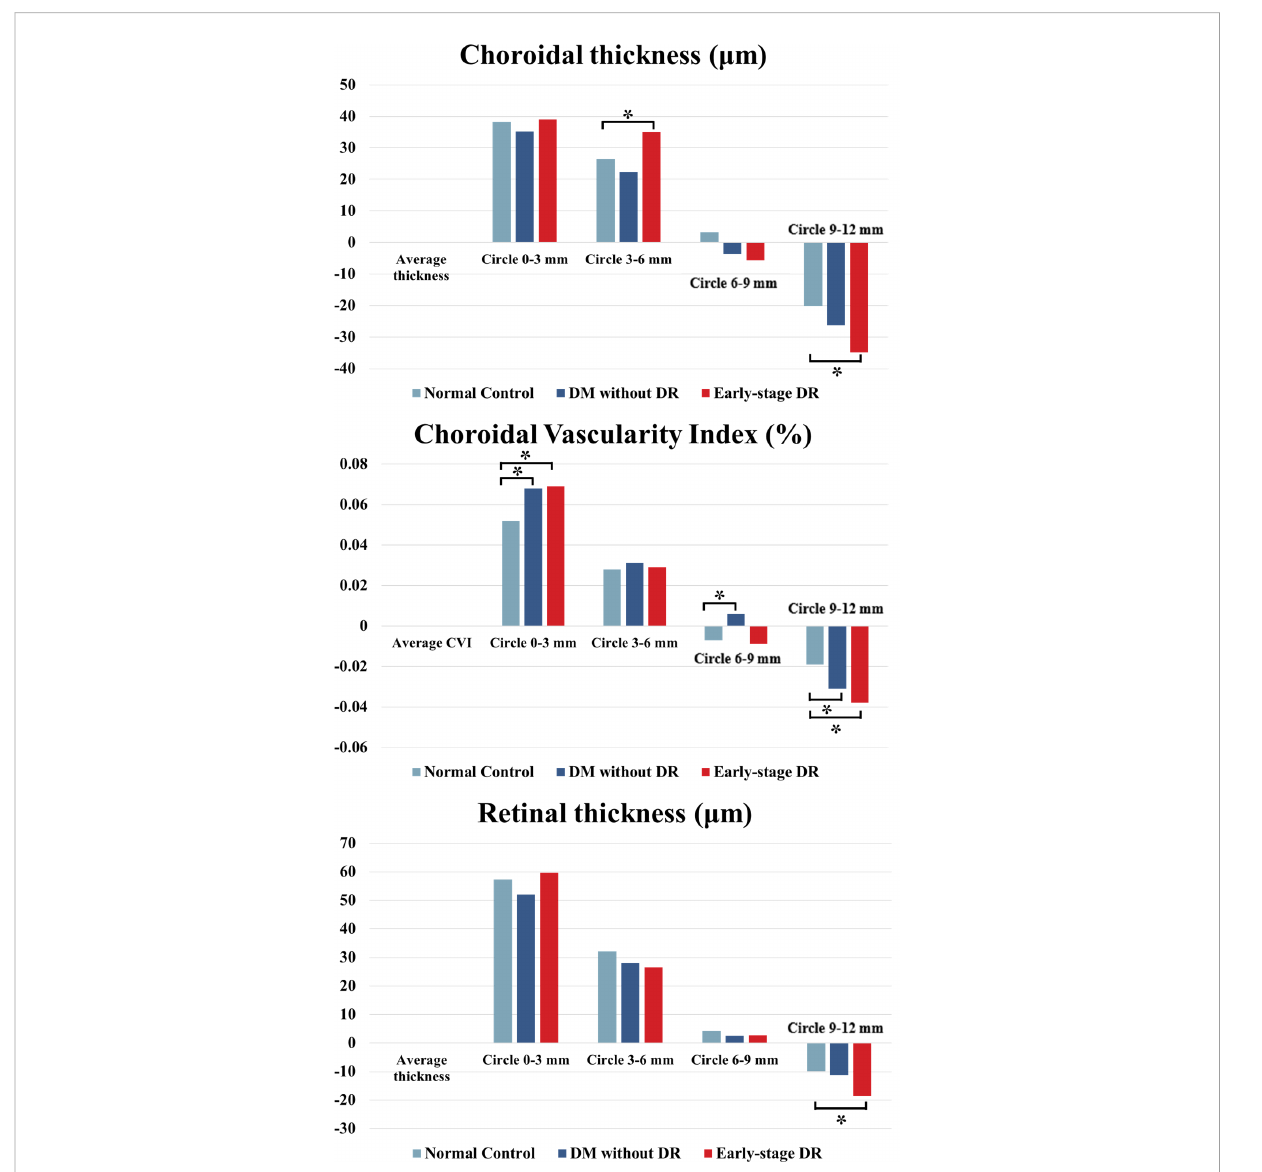
FIGURE 3 ChT, CVI and CMT changes in different fundus zones (Circle x-y vs . Average density) in patients with early-stage DR, diabetes mellitus without ophthalmoscopic signs of DR and non-diabetic subjects of the control group. * indicates a statistically signi fi cant difference (p <